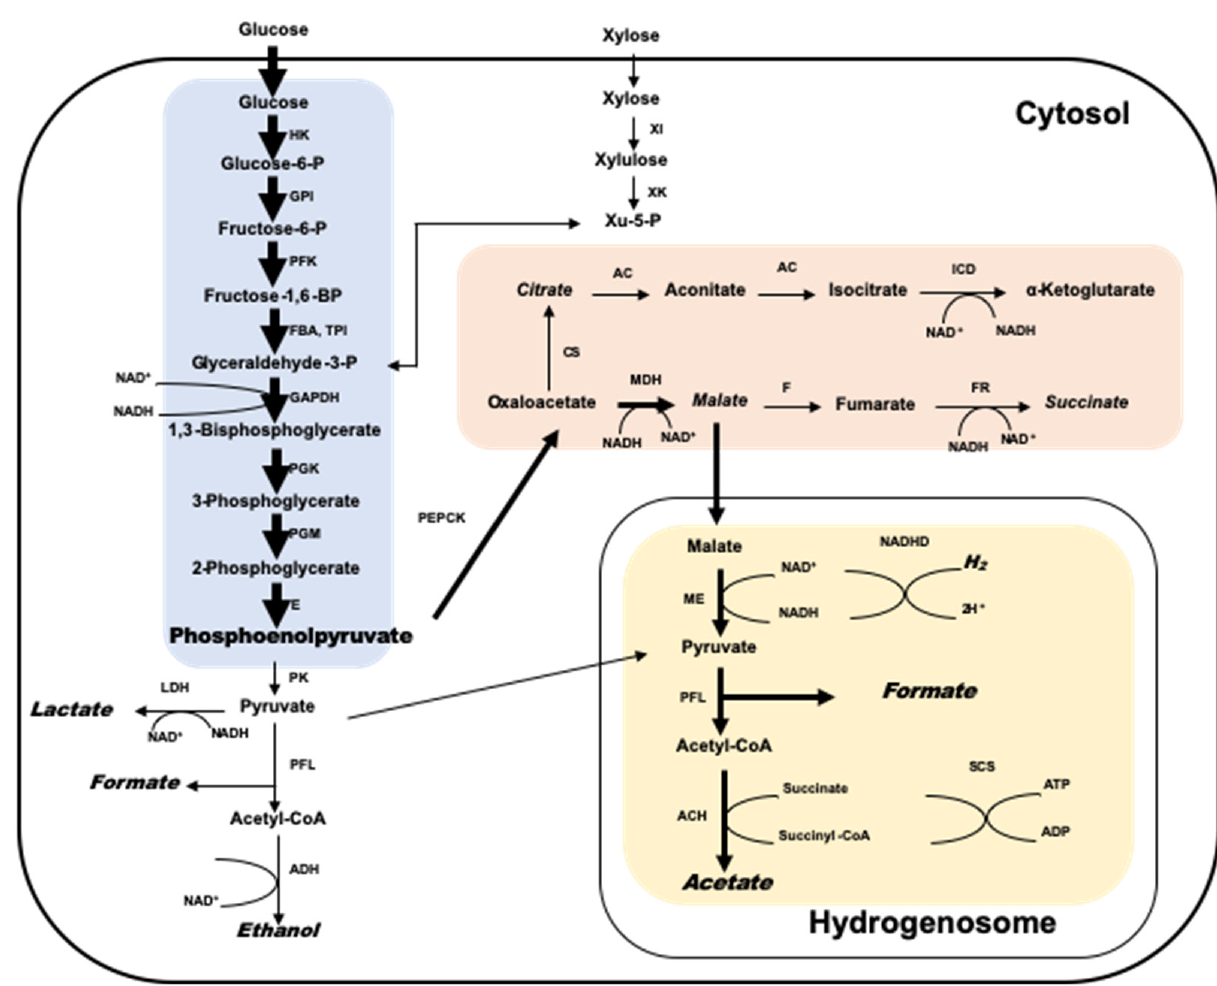
Figure 1. Glucose and xylose metabolism by anaerobic fungi. The main path is indicated by bold arrows. The proposed metabolites are indicated in italics. AC, aconitase; ACH, acetyl-CoA hydrolase; ADH, alkoholdehydrogenase; CS, citrate synthase; E, enolase; FBA, fructosebisphosphate aldolase; F, fumarase; FR, fumarate reductase; GAPDH, glyceraldehyde-3-phosphate dehydrogenase; GPI, glucose-6-phosphate isomerase; HK, hexokinase; ICD, isocitrate dehydrogenase; LDH, lactatedehydrogenase; MDH, malate dehydrogenase; ME, malic enzyme; NADHD, NADH dehydrogenase; SCS, succinyl-CoA synthetase; TPI, triosephosphate isomerase; XK, xylulokinase; XI, xylose isomerase; PFK, phosphofructokinase; PFL, pyruvate formate lyase; PGK, 3-phosphoglycerate kinase; PGM, phosphoglucomutase; PK, pyruvate kinase; PEPCK, phosphoenolpyruvate car- boxykinase.